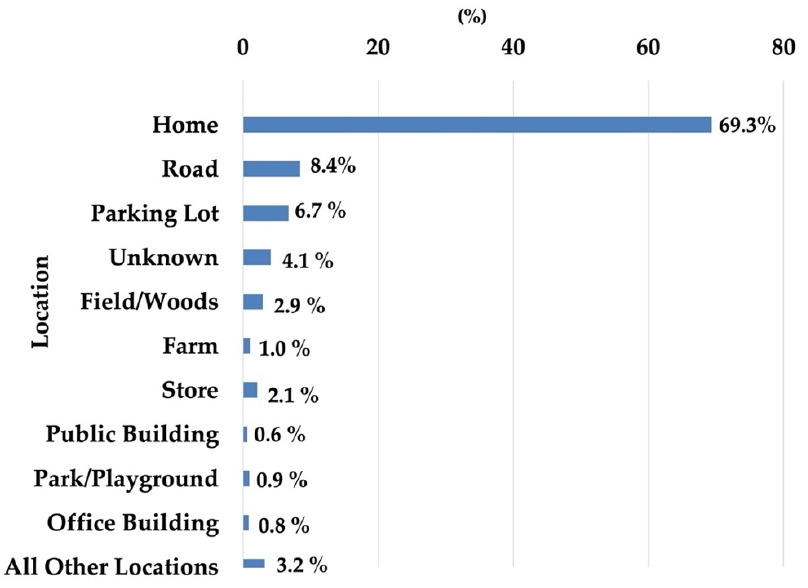
Figure 3. Location of 2019 Animal Cruelty Incidents (%).